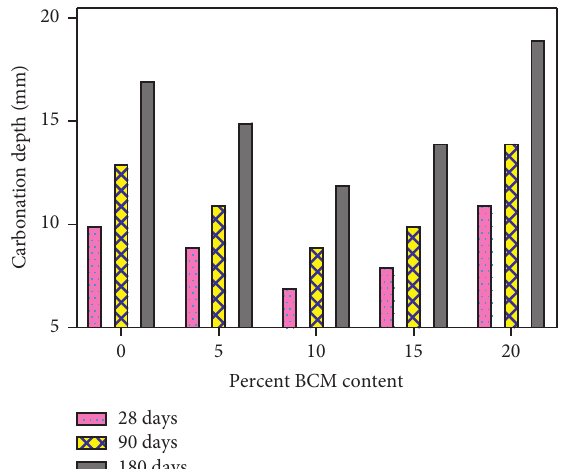
Figure 8: Carbonation depth of concrete containing BCM.